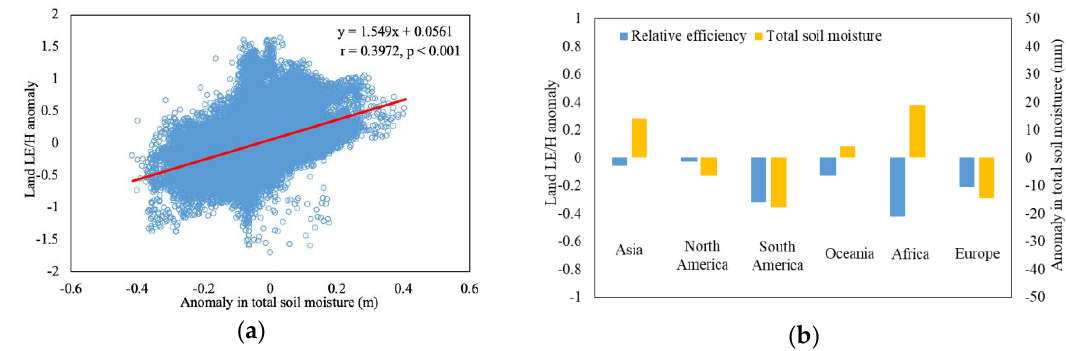
Figure 7. Relative e ffi ciency and total soil moisture anomalies over global land in the RCP8.5 scenario across the CMIP5 simulations. ( a ) Relationship between relative e ffi ciency anomaly and total soil moisture anomaly over individual land grids. ( b ) Mean relative e ffi ciency and total soil moisture anomalies over continents.